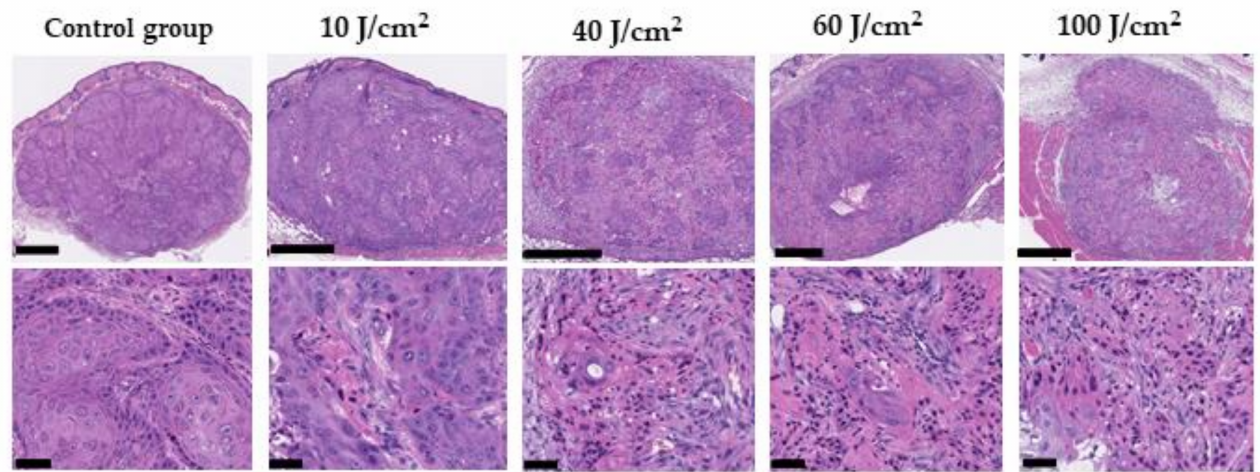
Figure 5. Histological findings 24 h after PIT with various laser doses. Histological specimens of A431 tumors with no treatment and PIT of 10, 40, 60, and 100 J/cm 2 are shown. All specimens are stained with hematoxylin and eosin. Scattered clusters of damaged tumor cells are seen. (Upper black scale bar = 500 µ m, Lower black scale bar = 50 µ